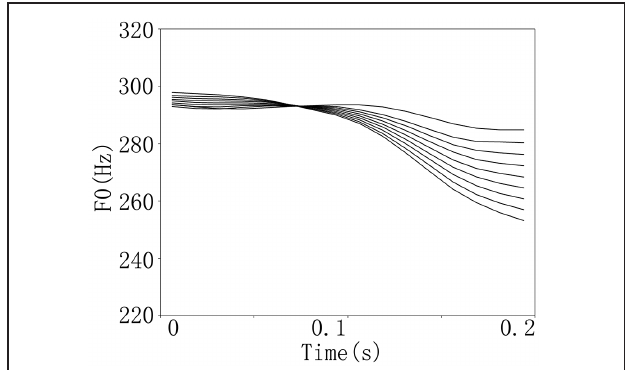
FIGURE 1 | Tone contours of the continuum from /ba1/ to /ba4/.